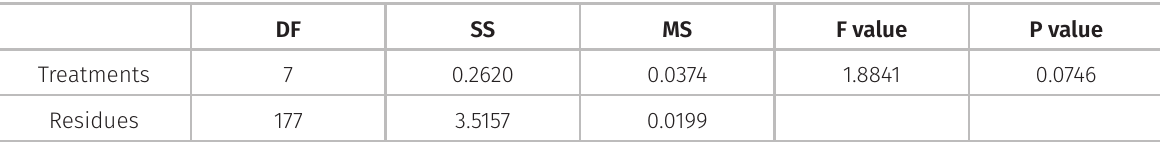
Table IV. Analysis of variance of the RE of the jejunum of cadavers of cats chemically preserved under the acute effect of conservation for seven days.